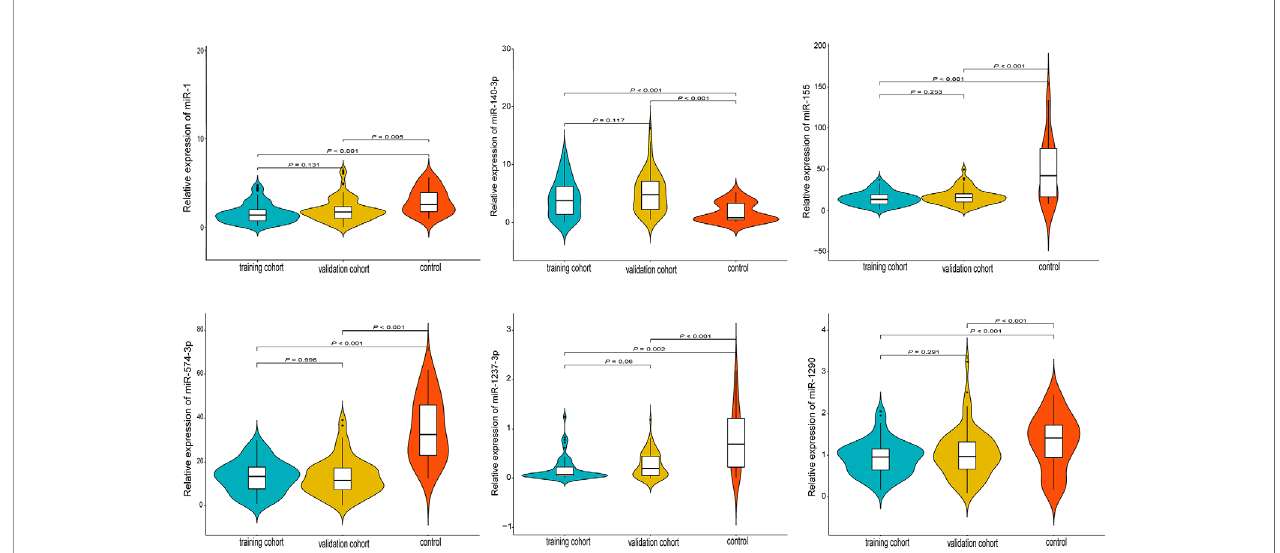
FIGURE 1 | Quantitative expression levels of the six prognostic miRNAs by RT-PCR in the training, validation and control groups. All miRNAs were differentially expressed in tumor tissues compared with nucleus pulposus tissues (as